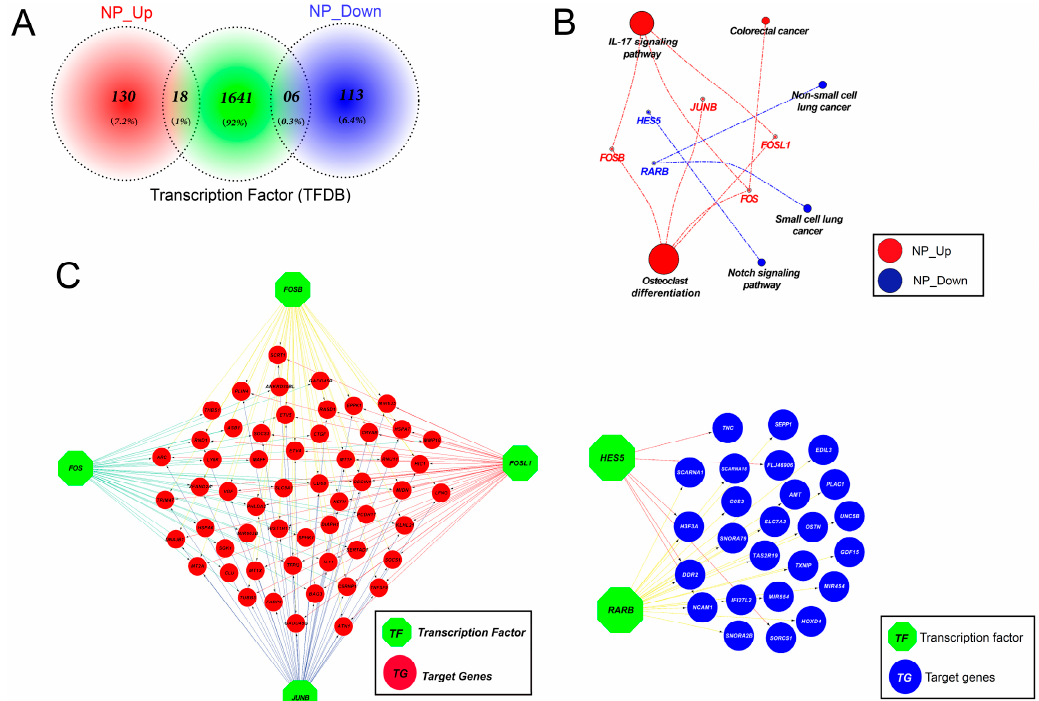
Figure 11. Graphene oxide altered transcription factor (TF) expression, resulting in changes to downstream gene expression. ( A ) Venn diagram showing TFs among the DEGs. Eighteen out of 148 upregulated genes and six out of 119 downregulated genes were identified as TFs. ( B ) KEGG analysis with TFs differentially expressed following graphene oxide exposure. Red color: Upregulated genes; blue color: Downregulated genes. ( C ) Networks showing differentially expressed target genes downstream of the TFs identified in ( A ).